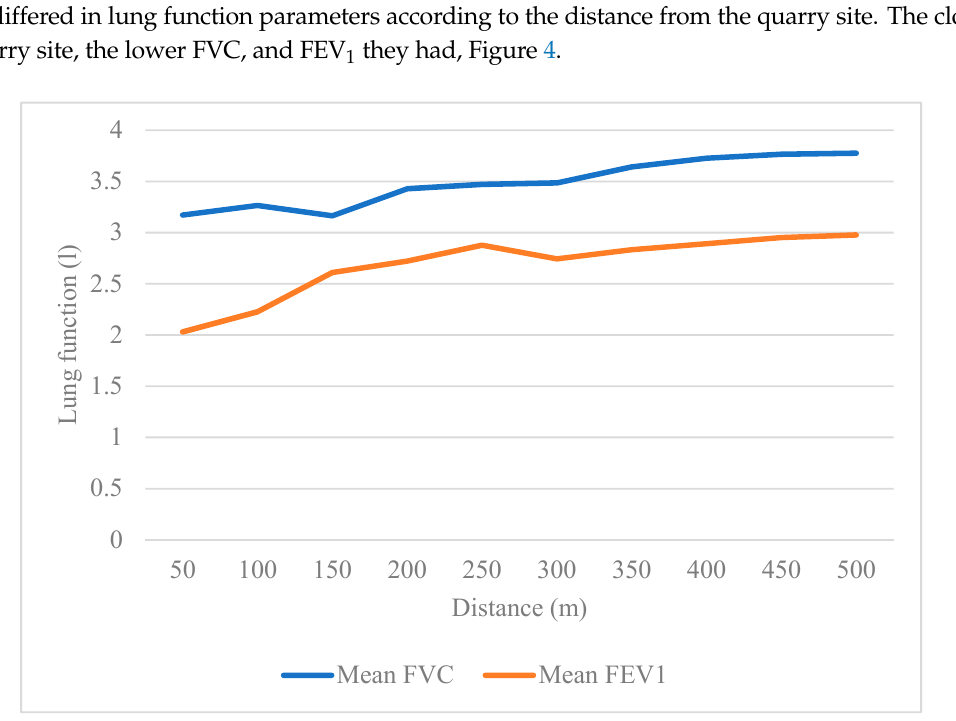
Results are presented as mean (% of predicted value) and SD: standard deviation. † Lung function di ff erences, using linear regression, are adjusted for sex, age, height, weight, and smoking. FVC: forced vital capacity. FEV 1 : forced expiratory volume in the first second.